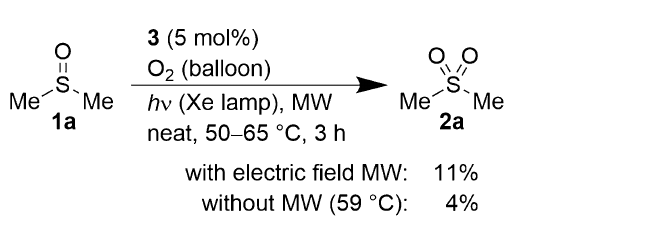
Figure 2. Effect of the electric field component of